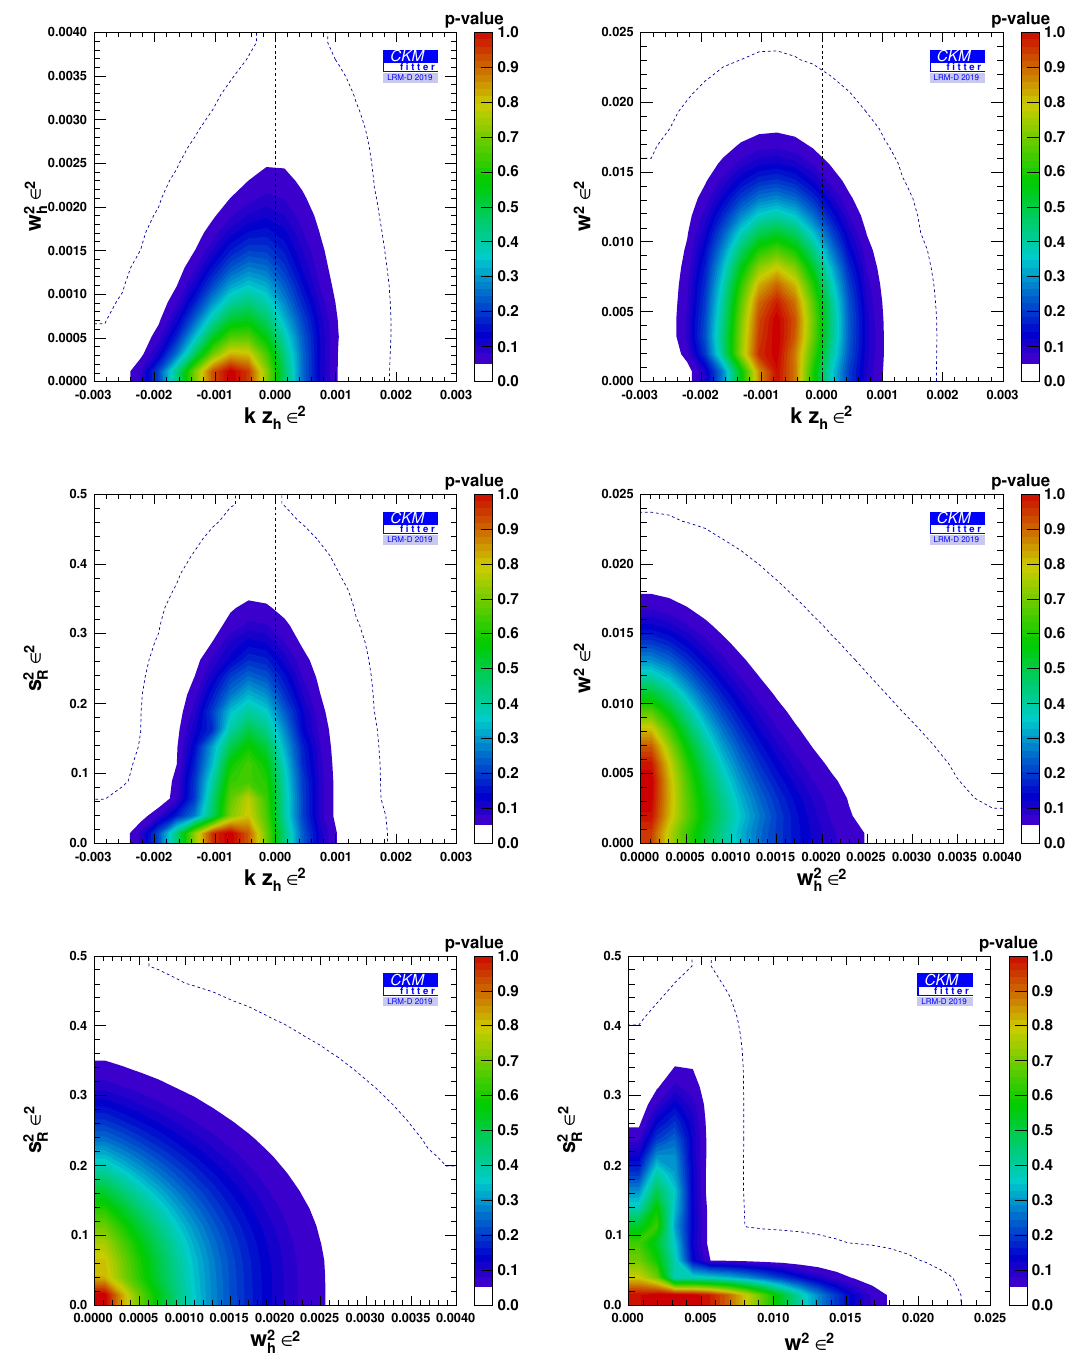
Figure 9 . Correlations between the combinations kz h (cid:15) 2 , w 2 are de(cid:12)ned in eq. (2.44) . The dotted lines set the 3 (cid:27) region.